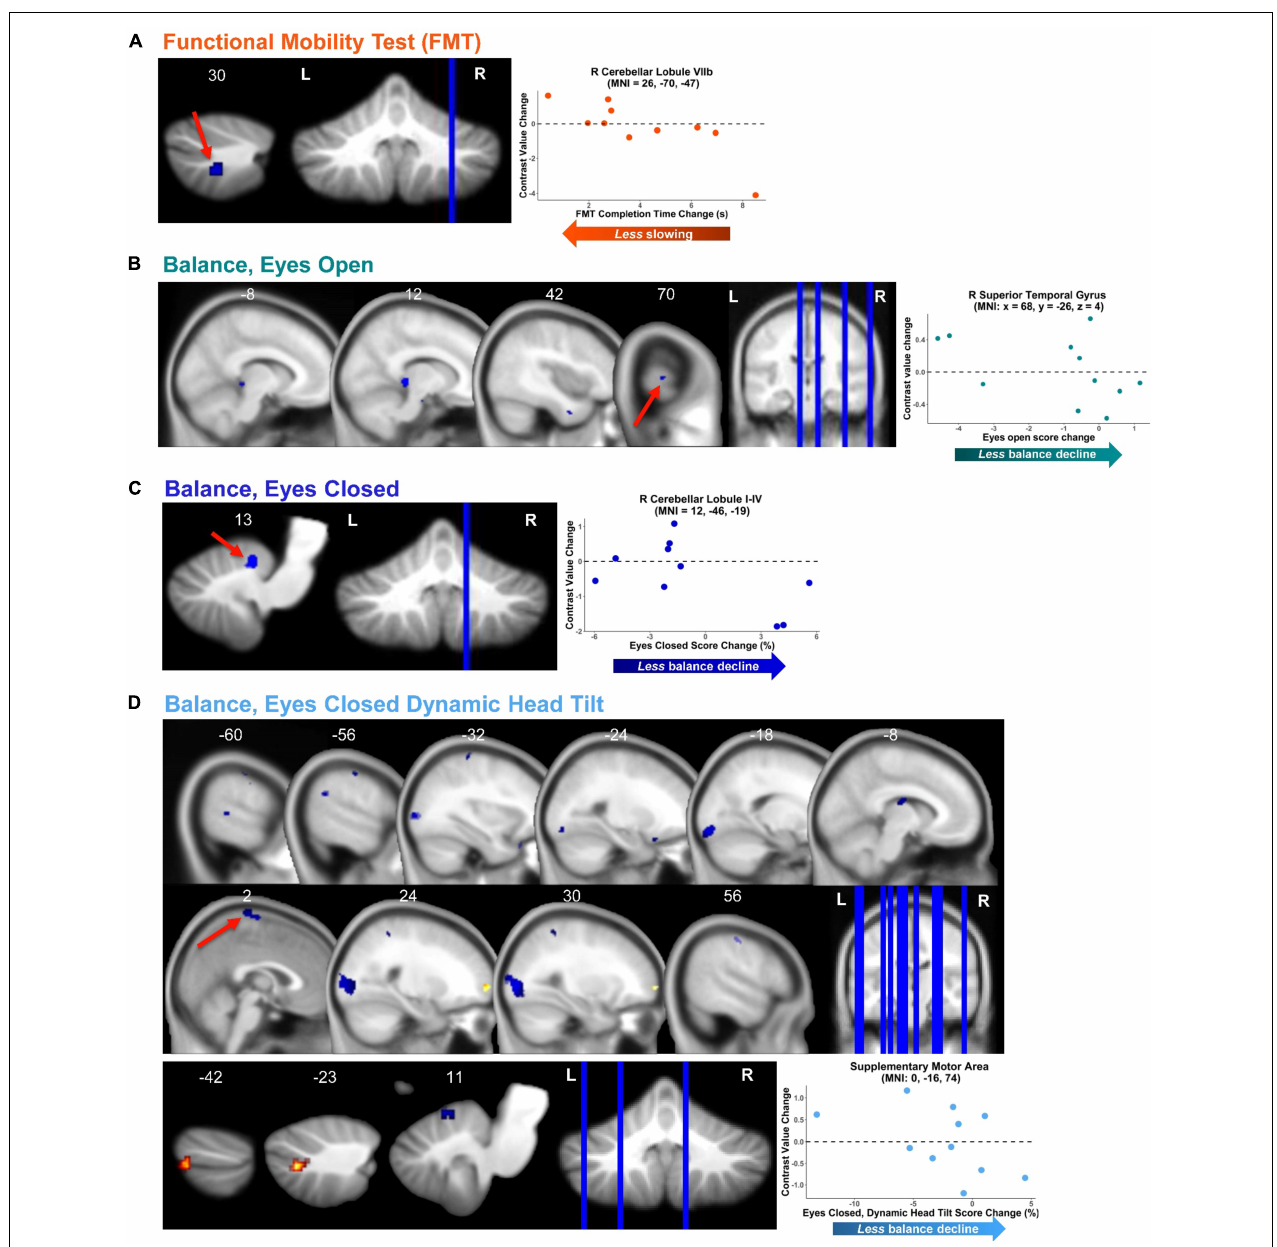
FIGURE 6 | Functional behavioral consequences. Brain—behavior correlations for functional mobility test (FMT; A ) and three balance tasks (B–D) . Brain change was calculated as the difference in brain activation from pre-HDBR + CO 2 (time BDC 7) to the end of HDBR + CO 2 (time HDT 29). Behavior change was calculated as the difference in mobility and balance performance from pre-HDBR + CO 2 (time BDC 7) to post-HDBR + CO 2 (time R0). Whole brain and cerebellar results are overlaid onto MNI and SUIT standard templates, respectively; non-parametric p < 0.0005, k = 10. Warm colors indicate regions of positive correlation between brain change and behavior change. Cool colors indicate regions of negative correlation between brain change and behavior change. Right side correlation plots include contrast values extracted from peak coordinate inside an example cluster (indicated with red arrows), graphed against behavior change